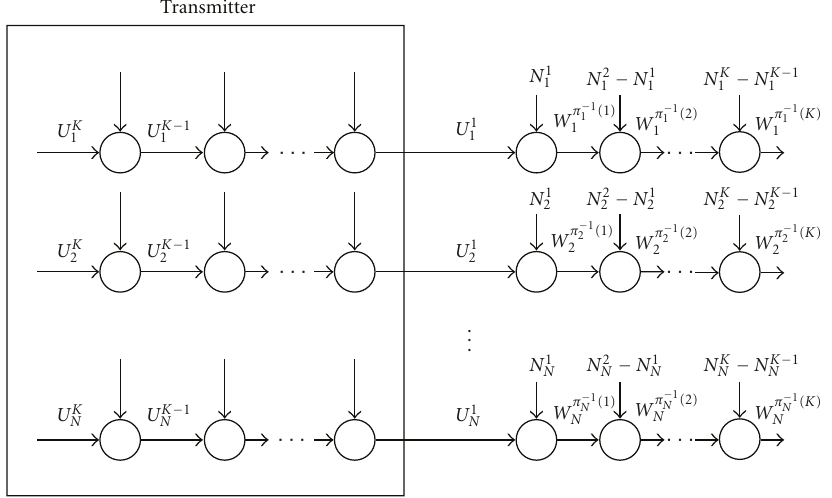
Figure 1: The product of N unmatched parallel degraded broadcast subchannels with K